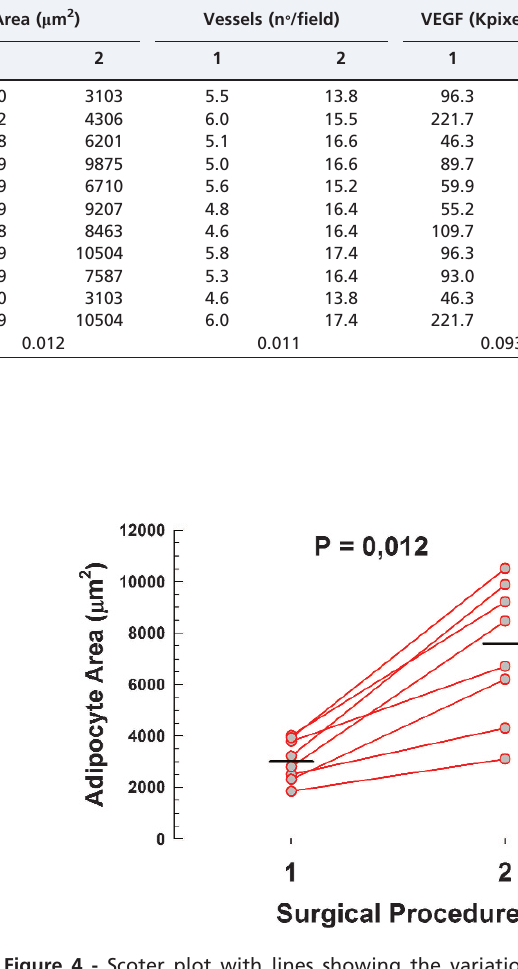
Figure 2 - Scoter plot with lines showing the variation of the adipocyte perimeter between surgical procedure 1 and 2. Short thick lines represent the series median values.